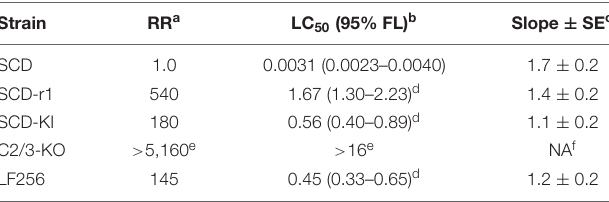
TABLE 2 | Responses to Cry1Ac by larvae from the susceptible SCD strain and four resistant strains of H. armigera